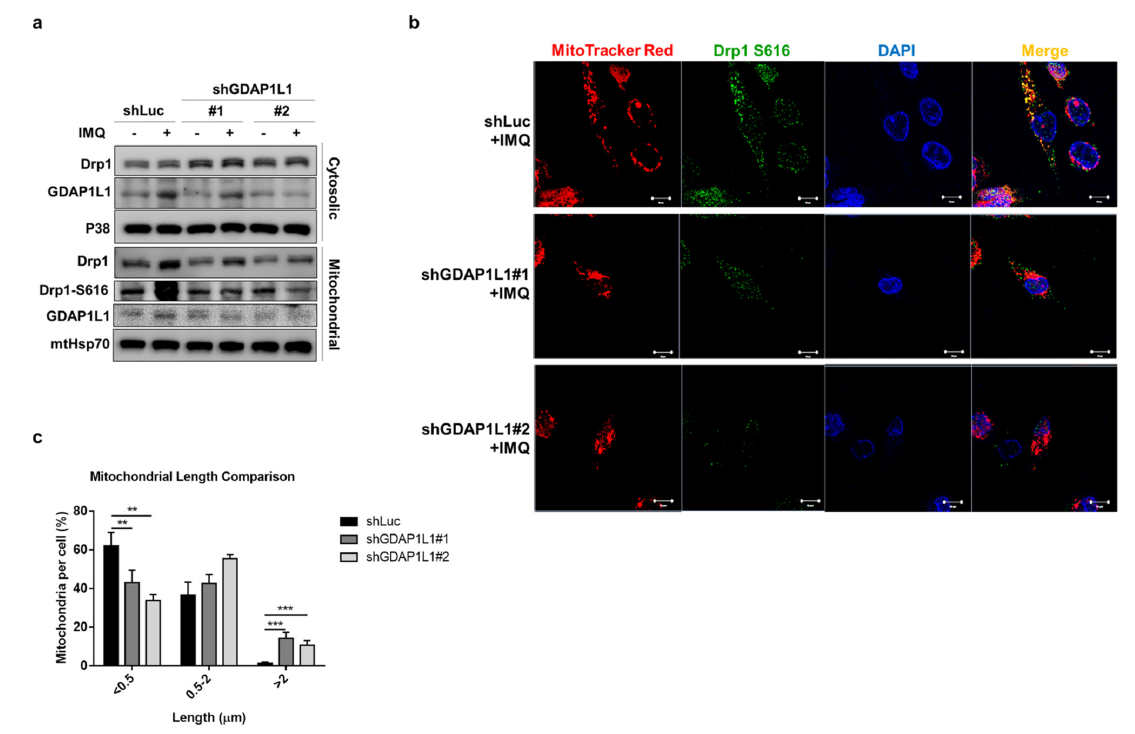
Figure 3. Loss of GDAP1L1 ameliorated Drp1 phosphorylation and mitochondrial translocation. Control and GDAP1L1- deficient THP1 macrophages were stimulated with IMQ (10 μ g/mL) for 2 h. ( a ) Cells were fractionated into cytosolic and mitochondrial fractions and subjected to immunoblotting using the indicated antibodies. ( b ) Cells were stained with MitoTracker Red and fixed and immunostained with antibodies against GDAP1L1 and Drp1 S616, followed by confocal microscopy. Nuclei were stained blue using DAPI. ( c ) Average mitochondrial length ( μ m) and comparison of mitochondrial length distribution in the indicated groups. Scale bars, 10 μ m. All experiments were repeated two or three times with similar results. Significant differences are indicated by ** p < 0.01 and, *** p < 0.001. Data are represented as mean ± SEM.